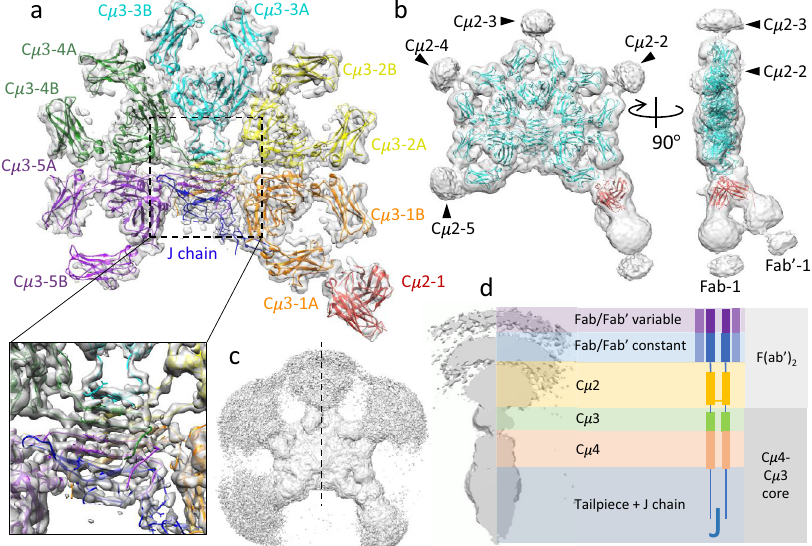
Fig. 1 | The cryo-EM structure of FL-IgM. a Sharpened cryo-EM map of FL-IgM showingthehigh-resolutioncorestructure(threshold0.6).Globalresolution4.3Å. The model docked in C μ 4-C μ 3 areas is IgM core model (pdb id 6KXS, with the secretory component (SC) domain removed) with a unique colour assigned for eachsubunit(subunit1,orange;subunit2,yellow;subunit3,cyan;subunit4,green; subunit 5, purple). The model docked in the C μ 2 domain of subunit 1 is the X-ray modelofmouse C μ 2dimer (red,pdb id4JVU). Theinset isthe zoom-inview ofthe tailpiece and J-chain region, where individual beta-strands are resolved (local resolution 3.5Å, see maps for tailpiece and J-chain segments in Supplementary Fig. 2). The resolution of the map decreases along the radial directions from the centre, with 4-5Å resolution at the C μ 4 domains and 5.5-7.5Å at the C μ 3 domains